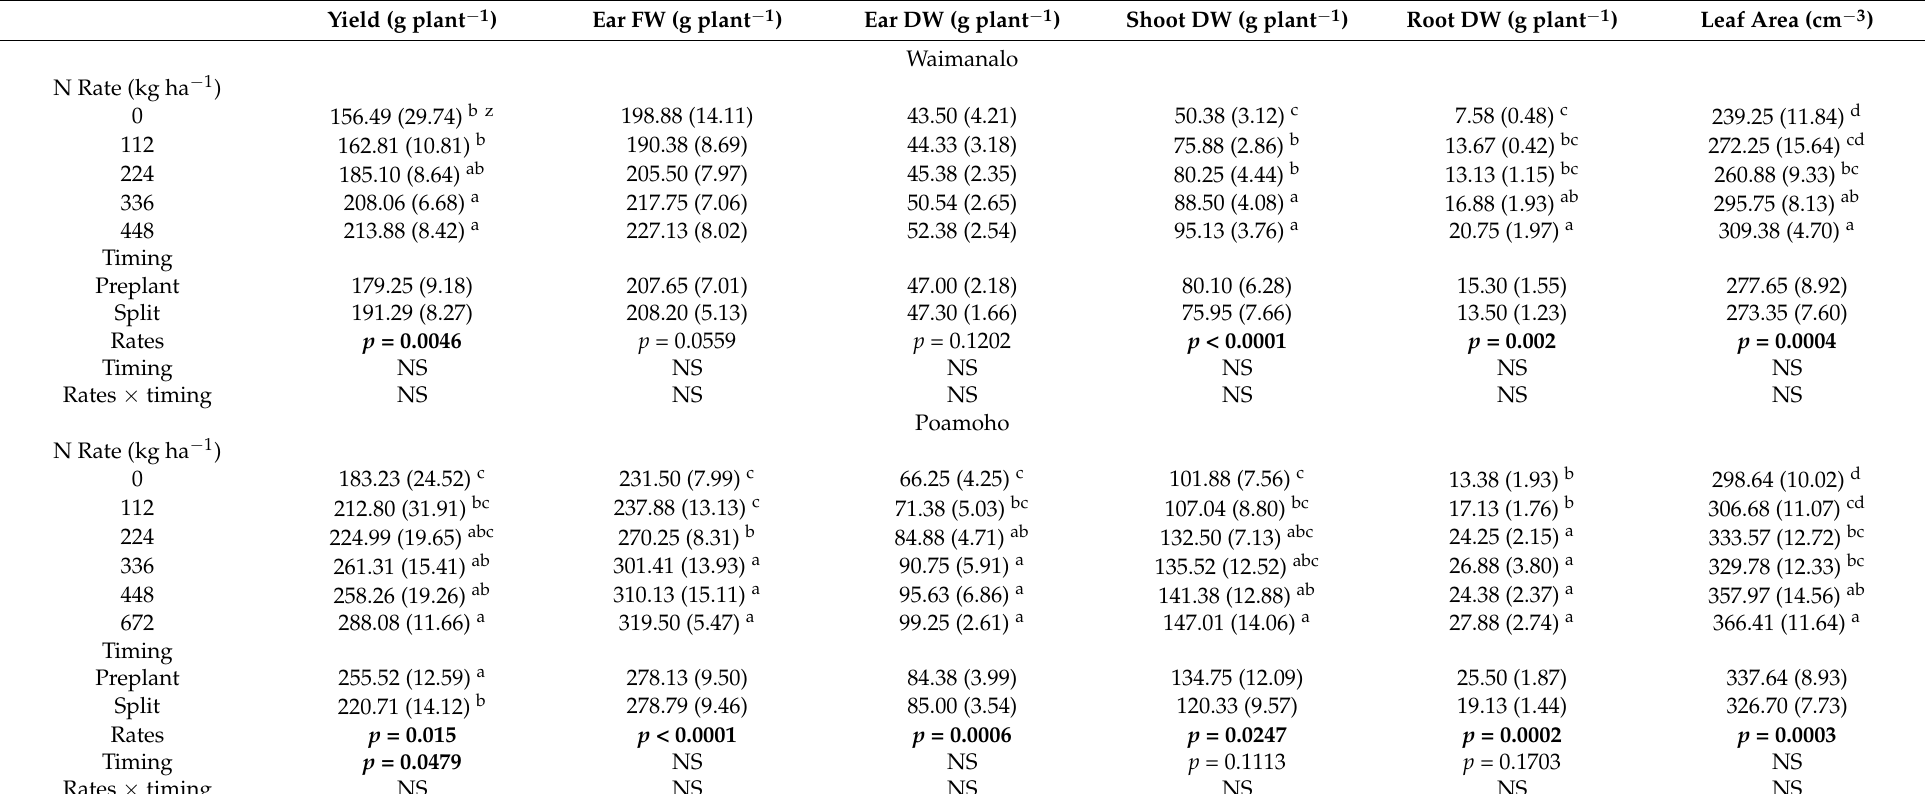
Table 3. Mean (SE) growth and yield components of sweet corn grown in field trials receiving meat and bone meal at two locations in Oahu,